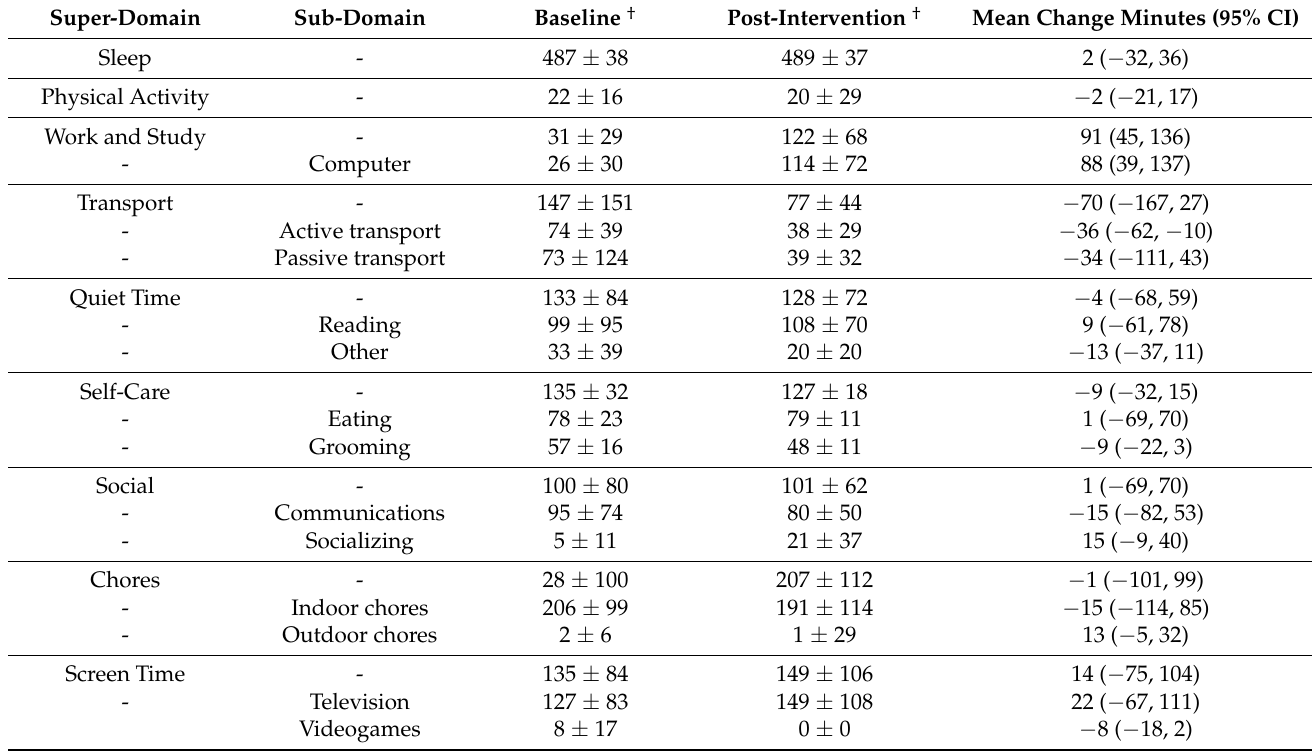
Table 3. Time Spent in Each Activity Super- and Sub-Domain during the Telehealth Intervention. Super-Domain